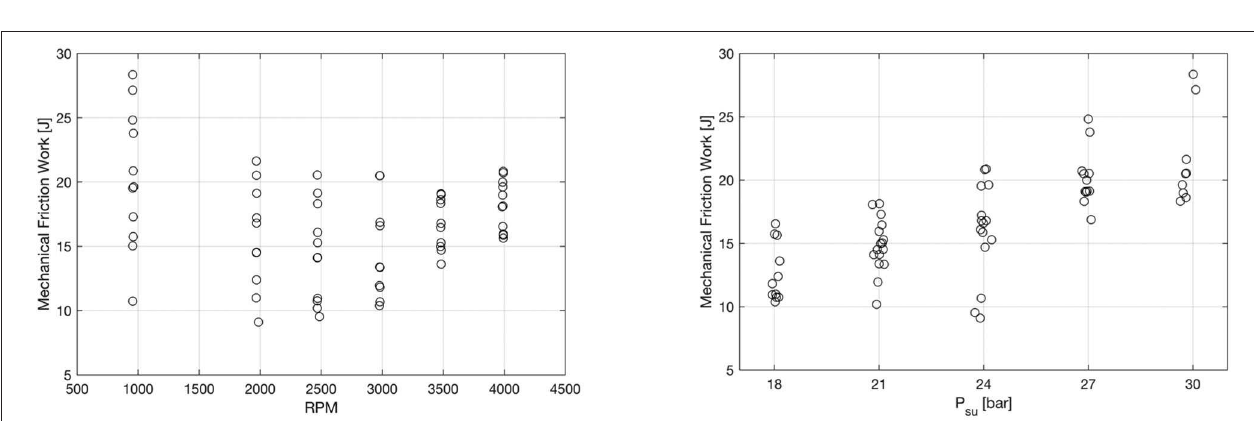
FIGURE 6 | Evolution of mechanical friction work in terms of rotational speed (left) and supply pressure (right)